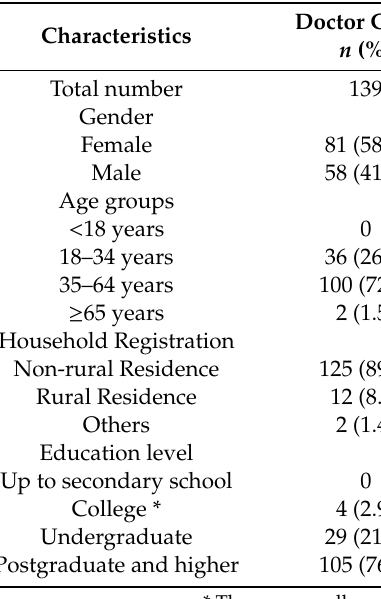
Table 1. Demographic characteristics of surveyed doctors and